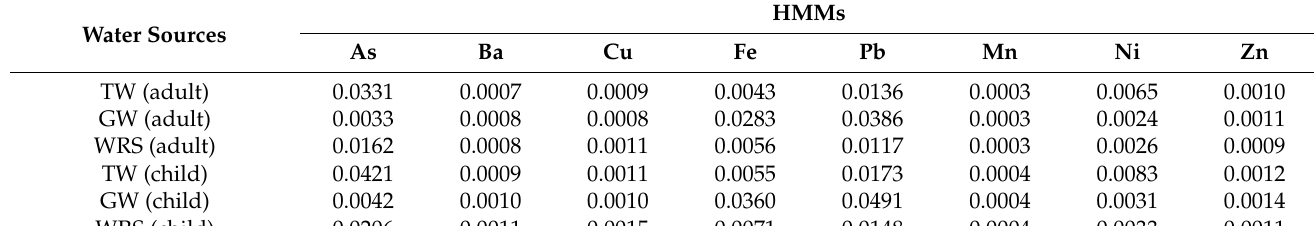
Figure 3. Average HMM concentrations in all DW samples.